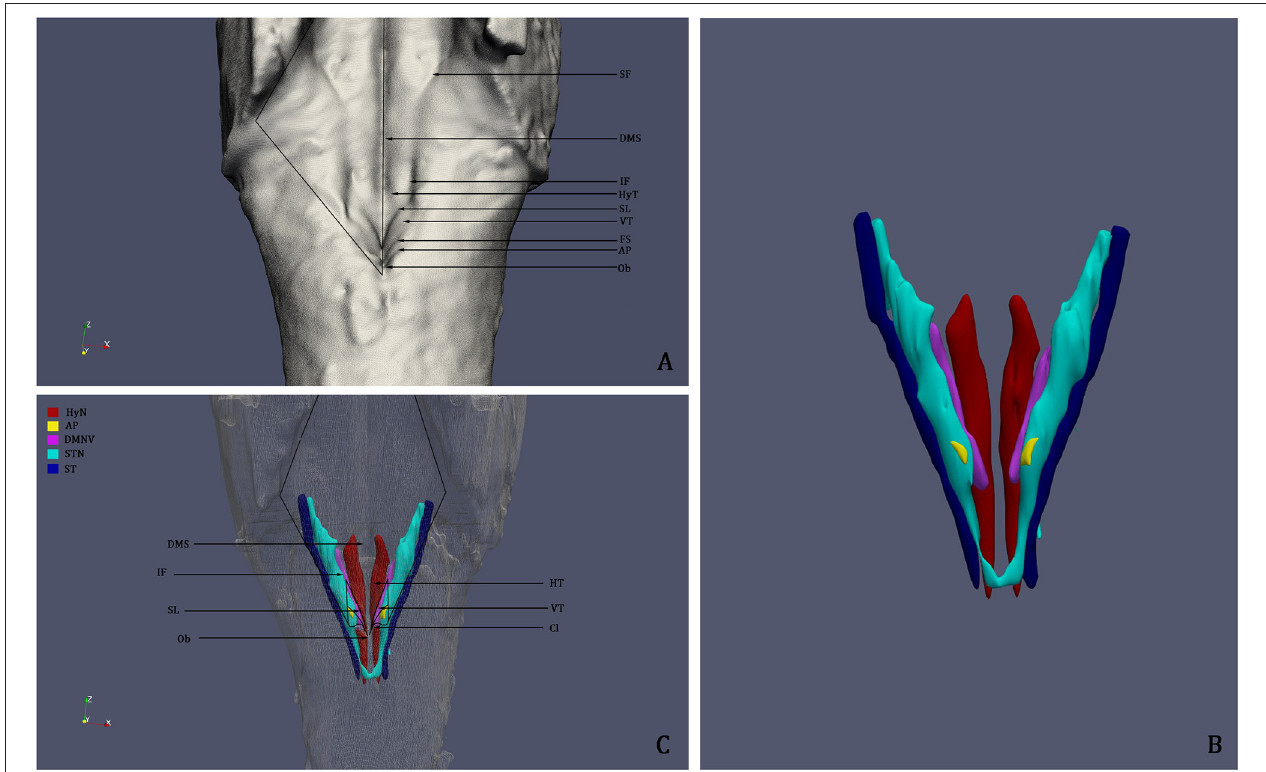
FIGURE 5 | (A) 3D reconstruction and rendering of the Human Brainstem, perspective on the Rhomboid Fossa. (B) 3D reconstruction of the nuclei of the brainstem tegmentum; (C) Surface projection of the nuclei of the tegmentum on the floor of the fourth ventricle; the rendering clearly shows that the Vagal Trigone (VT) contains both the Dorsal Motor Nucleus of the Vagus and the Solitary Tract Nucleus. DMS, Dorsal Median Sulcus; SF, Superior Fovea; IF, Inferior Fovea; SL; Sulcus Limitans; FS, Fasciculus Separans; HT, Hypoglossal Trigone; VT, Vagal Trigone; Ob, Obex; HyN, Hypoglossal Nucleus; AP, Area Postrema; DMNV, Dorsal Motor Nucleus of the Vagus; STN, Solitary Tract Nucleus; ST, Solitary Tract.